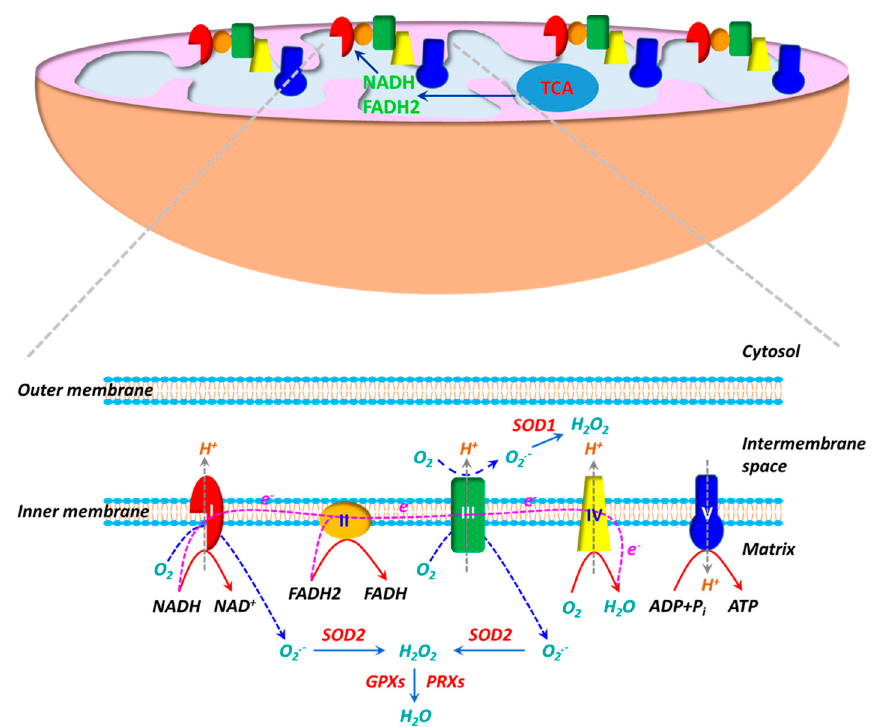
Figure 1. The mitochondrion is the powerhouse in living cells. ATP, the “energy currency”, is syn- thesized during oxidative phosphorylation. Oxidative phosphorylation is carried out by a series of multi-heteromeric protein complexes (Complexes I-V) of the electron transport chain (ETC) located in the inner mitochondrial membrane. Electrons from NADH and FADH2 produced in tricarboxylic acid (TCA) cycle flow through Complexes I/II to Complex IV, where O 2 serves as the final electron acceptor to generate H 2 O. During the electron transfer, protons (H + ) are pumped out of the mitochondrial matrix into the intermembrane space at Complexes I, III and IV, resulting in a proton gradient and a transmembrane electrical potential. The energy stored in proton gradient is used to synthesize ATP from ADP when protons flow back through Complex V (ATP synthase). The mitochondrion is also an important source of reactive oxygen species (ROS). The electron flow in ETC is not perfect and a fraction of electrons are leaked at Complexes I/III, leading to partial reduction of O 2 to generate superoxide (O 2 •− ). O 2 •− generated at Complex I is released into the matrix, whereas O 2 •− produced at Complex III is delivered into both the matrix and the intermembrane space. O 2 •− is then dismutated to H 2 O 2 by superoxide dismutase 1 (SOD1) in the intermembrane space and by SOD2 in the matrix. H 2 O 2 is subsequently decomposed to H 2 O by glutathione peroxidases